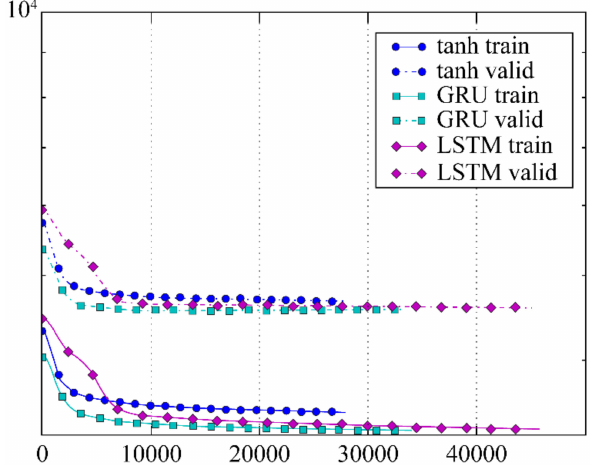
Figure 10. Learning curves for the training and validation sets of different types of units with respect to the wall clock time (seconds). The x-axis corresponds to the wall clock time (seconds) and the y-axis corresponds to the negative log likelihood of learning probability distribution over sequences in the log scale (Source: